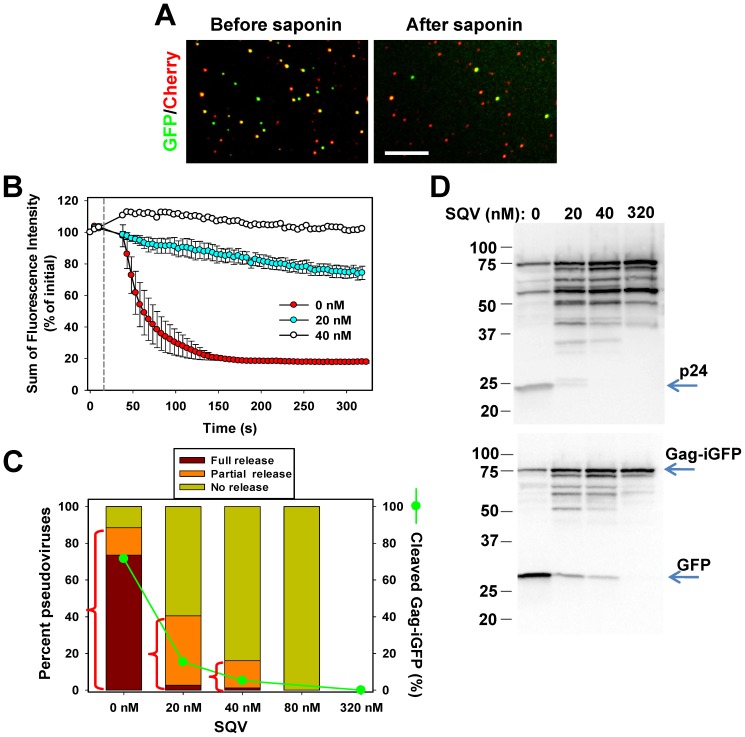
The fraction of a releasable GFP-based content marker correlates with the extent of HIV-1 maturation.(A) Lysis of pseudoviruses co-labeled with Gag-iGFP (content marker, green) and the Cherry-ICAM-1 chimera (membrane marker, red). Pseudoviruses immobilized on a coverslip (left) were exposed to saponin at 37°C (0.1 mg/ml in HBSS, right). Scale bar is 8 µm. (B) The extent and kinetics of HIV-1 pseudovirus lysis. Gag-iGFP-labeled viruses produced in the presence of escalating doses of saquinavir (SQV) were immobilized onto coverslips and imaged. After the first three images, the acquisition was paused, saponin was added at the final concentration of 0.1 mg/ml, and imaging was continued for ∼5 min at 37°C. The total fluorescence of all iGFP-positive particles as a function of time was calculated for each experiment and the average fluorescence profile from 4–5 independent experiments were plotted (error bars are SEM). The fluorescence profile for 40 nM SQV-treated viruses is the mean from 2 independent experiments. (C) Pseudoviruses co-labeled with Gag-iGFP and DiD exhibit different degrees of iGFP release upon addition of saponin, from full or partial loss of content to no iGFP release. More than 200 particles were tracked for each SQV concentration. Red brackets show the total percentage of full and partial release events. Green circles show the fraction of free iGFP relative to the total amount of fluorescent protein obtained by densitometry analysis of bands shown in panel D. (D) The effect of escalating doses of SQV on HIV-1 Gag and Gag-iGFP cleavage. Pseudoviruses produced in the presence of indicated concentrations of SQV were analyzed by SDS-PAGE and blotted with antibodies to HIV-1 Gag/p24 (top panel) or with anti-GFP antibodies (bottom panel). The four intermediate bands on the GFP blot that run between Gag-iGFP and iGFP, likely correspond to MA-GFP-CA-NC, MA-GFP-CA, GFP-CA-NC and GFP-CA.